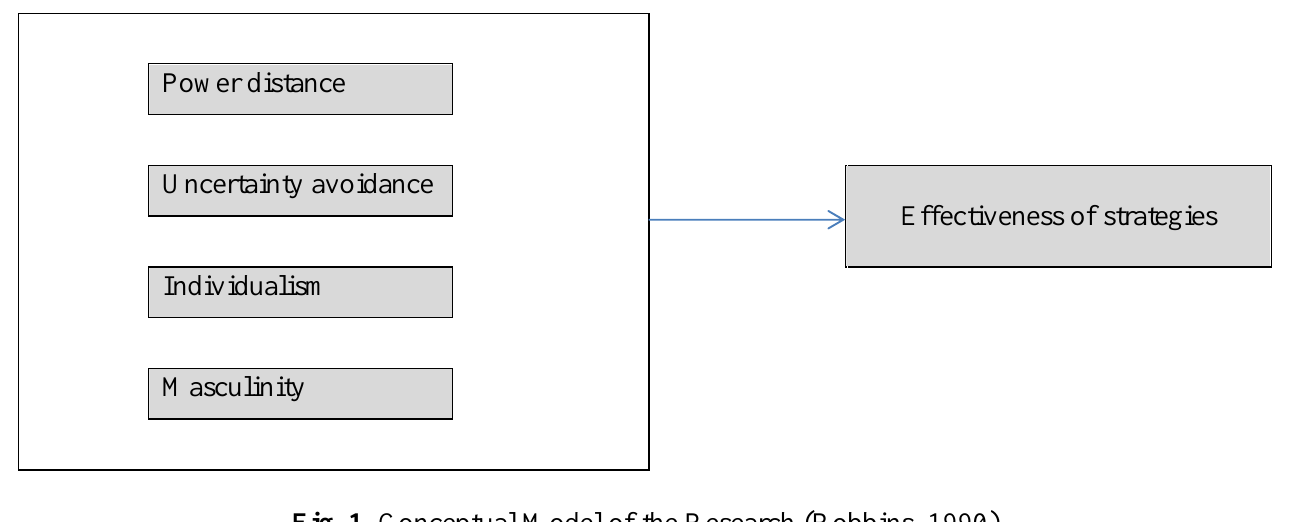
Fig. 1. Conceptual Model of the Research (Robbins,